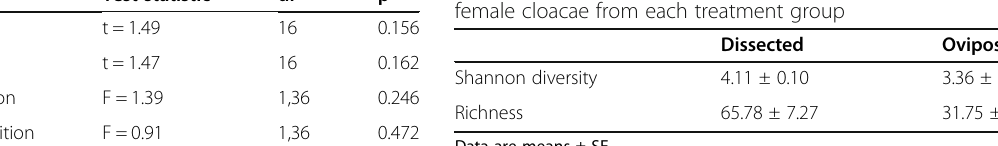
Table 3 Diversity metrics from laboratory swabs of S. virgatus female cloacae from each treatment